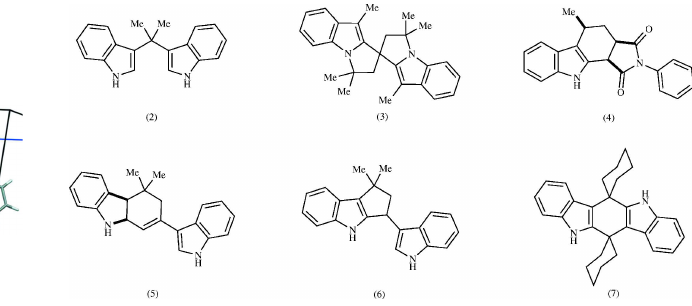
Figure 1 Contextual